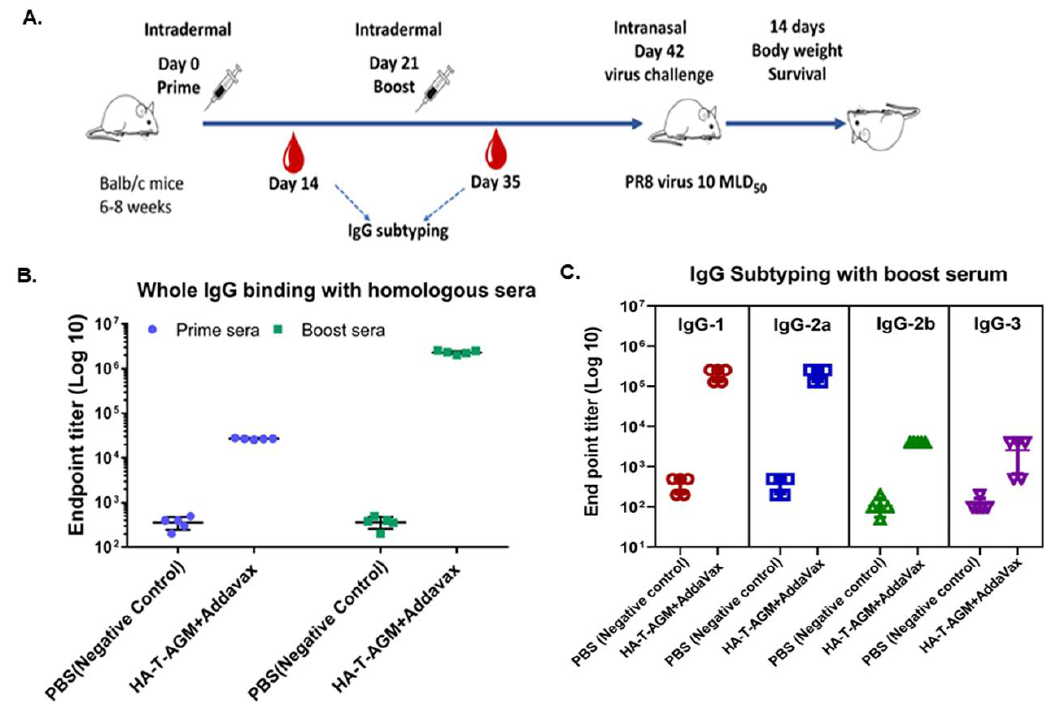
Figure 4. Immune response assessment after prime-boost of HA-T-AGM in mice. ( A ): Schematic representation of antigen administration in BALB/c mice ( n = 5) for each test group and n = 5 for naïve control group). The black needle shows the dosage time point, while the red blood drop indicates the time of blood collection. ( B ): IgG whole (H+L) binding with boost sera using homologous protein and mice group sera. ( C ): IgG subclass IgG1, IgG 2a, IgG 2b, and IgG3 identification from mouse sera as indicated by ELISA using anti-mouse IgG subtype secondary antibody tagged with HRP. Values plotted are the geometric mean titers mean ± S.E. of triplicate wells.